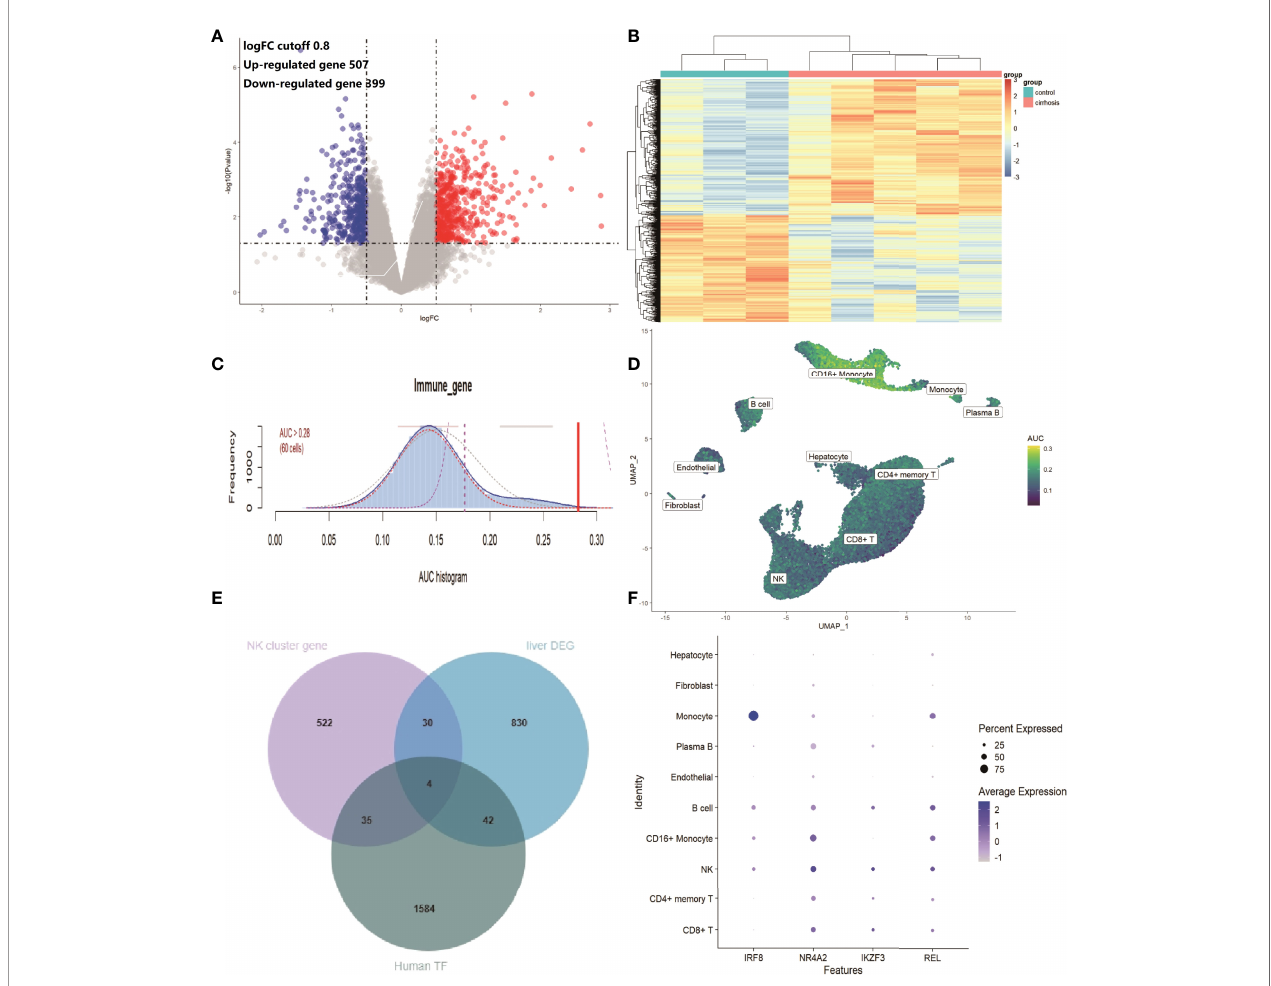
FIGURE 5 | IRGs and relevant regulatory TFs of cirrhosis from the GSE45050 dataset. (A) Volcano plot of DEGs (|logFC| > 0.8 and adjusted P value < 0.05). Up- regulated genes are colored red and down-regulated genes are colored blue. (B) Heatmap of the top 100 up-regulated and top 100 down-regulated DEGs. (C) Score of 103 IRGs. The threshold was chosen as 0.28. (D) UMAP plots of the IRG score in all clusters. CD16+ monocytes and NK cells express more genes and exhibit higher AUC values. (E) Venn plot showing TFs in the NK cluster of the GSE136103 dataset, Human TF database, and TFs in DEGs of the GES45050 dataset. (F) Dot plot of the 4 identi fi ed common